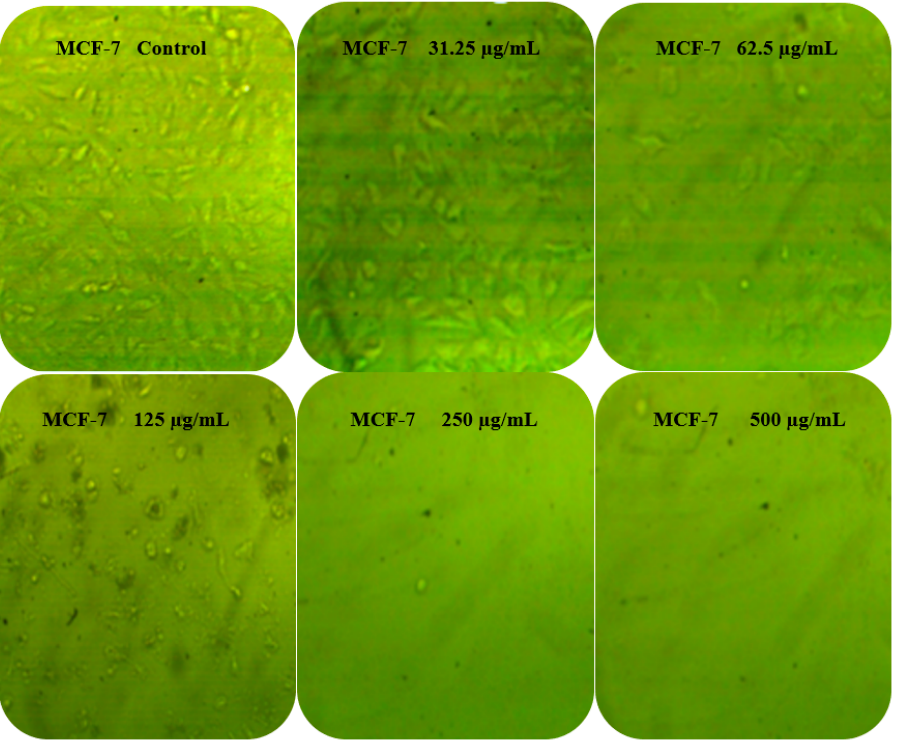
Figure 8. Effect of different concentrations of latex on morphological changes of PC-3 and MCF-7. Magnification, 40 ×.